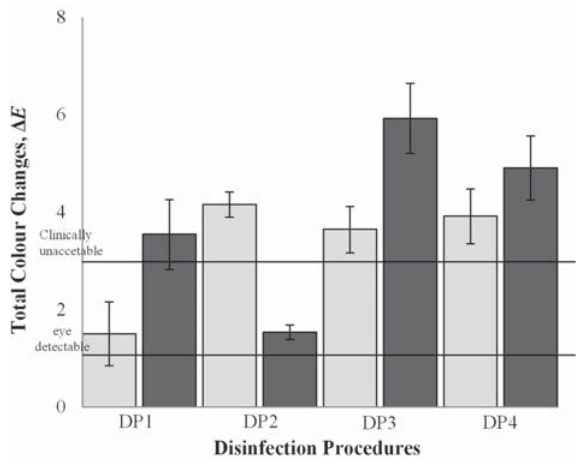
Figure 3- Mean values of total color differences and standard deviations for samples A (grey columns) and B (black columns) after the four different disinfected procedures